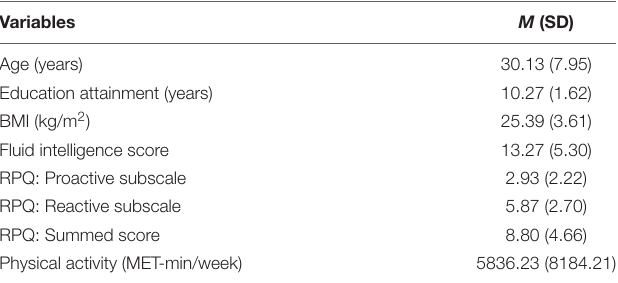
TABLE 1 | Descriptive statistics of demographic and questionnaire